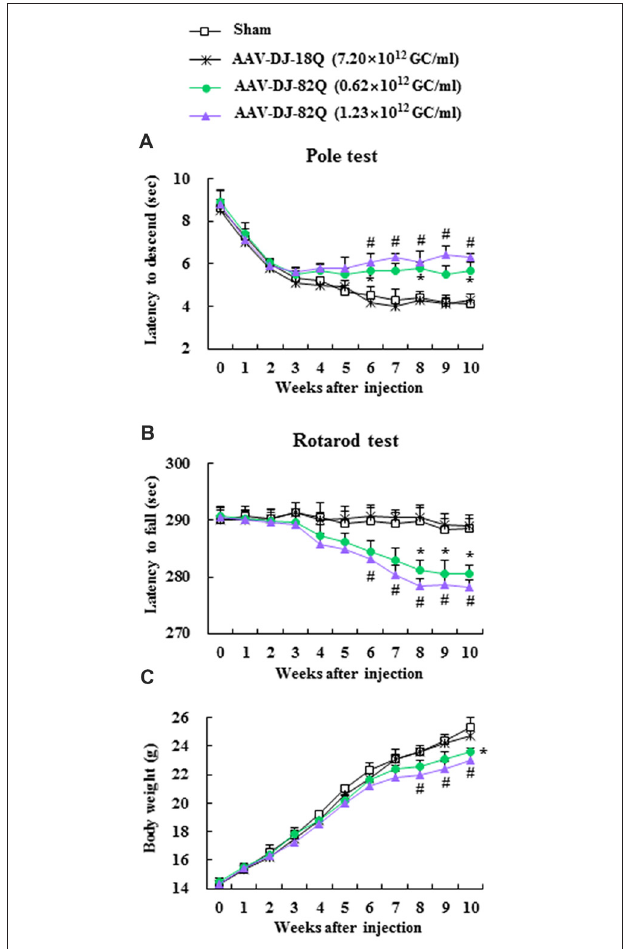
FIGURE 1 | Adeno-associated viral (AAV)-DJ-82Q-injection induces neurological impairment. Two microliters of AAV-DJ-82Q (0.62 × 10 12 GC /